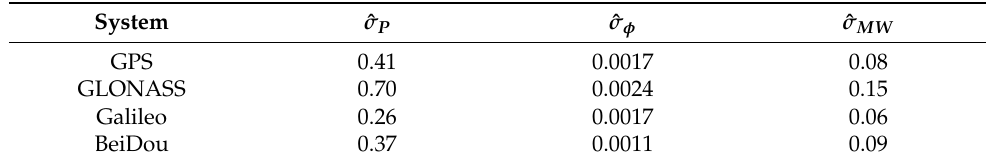
Table 2. Estimated STD of phase and code observations (meter).